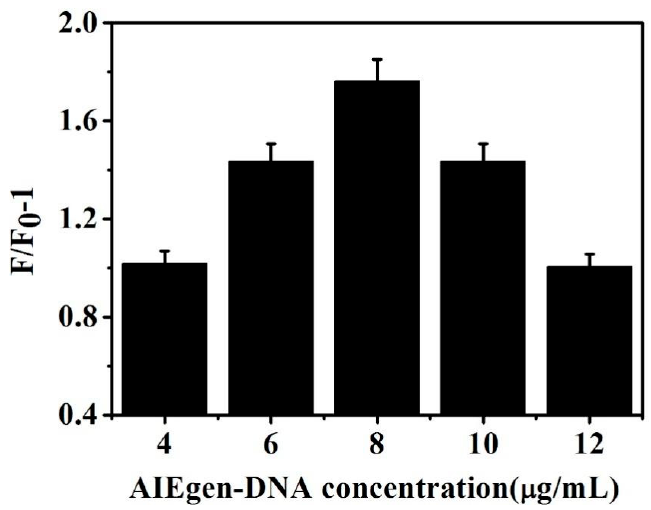
Figure 6. Effects of different concentrations of aptamer AIEgen-aptamer 2 on the fluorescence inten-